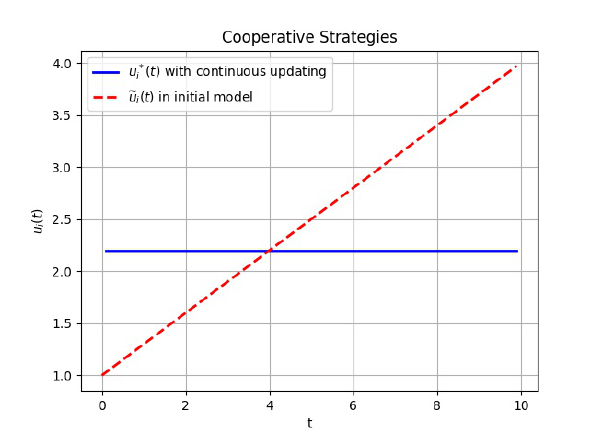
Figure 1. Cooperative strategies in the initial game (cid:101) u ( t ) (red line) and cooperative strategies with continuous updating u ∗ ( t ) (blue line).